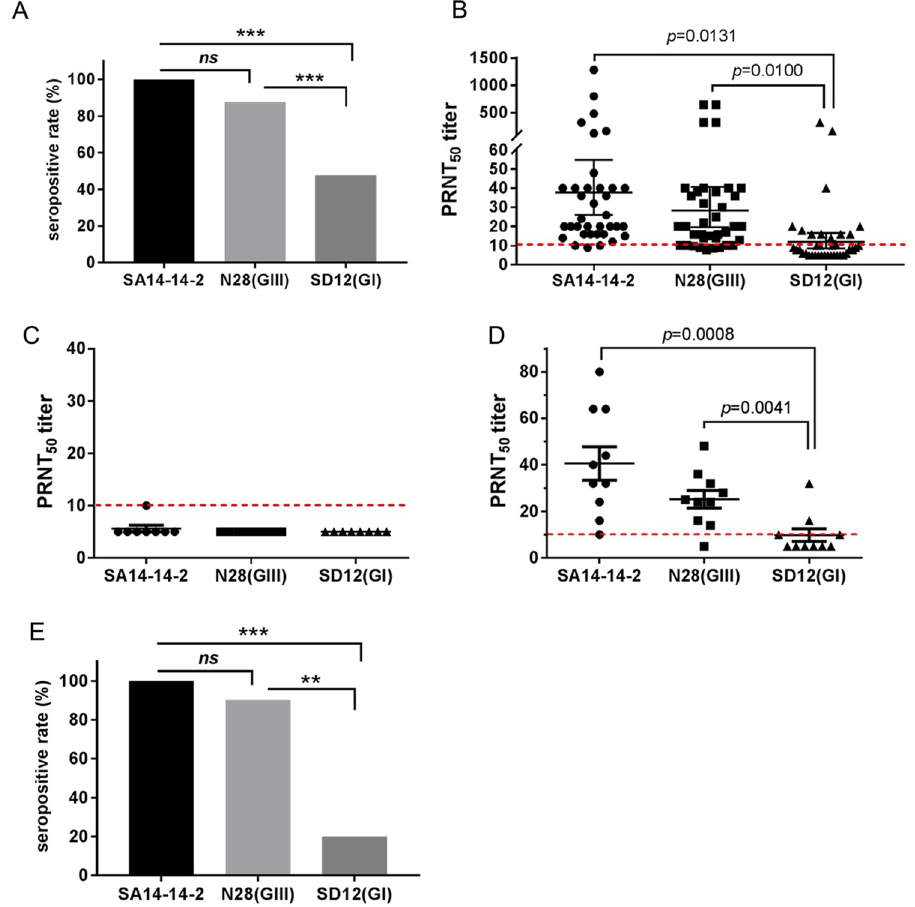
Fig 1. Detection of neutralizing antibody titers in pigs and mice vaccinated with the SA14-14-2 vaccine. (A and B) Pigs ( n = 40) were immunized with SA14-14-2 vaccine and serum samples for each animal were collected at 30 days post-vaccination for detection of neutralizing antibodies against SA14-14-2, N28(GIII) and SD12(GI) strains. (A) Seropositive rate against the indicated JEV strains. ��� , p < 0.001 detected by Fisher’s exact test. (B) Neutralizing antibody titers (PRNT 50 ) against the indicated JEV strains were measured on BHK-21 cells and plotted. A p value was generated by Student’s t -test. (C, D and E) Mice ( n = 10) were immunized with the SA14-14-2 vaccine and serum samples were collected at 14 days post-vaccination for detection of neutralizing antibodies against SA14-14-2 vaccine, N28(GIII) and SD12(GI) strains. (C) PRNT 50 titers in serum samples collected from pre-vaccinated mice. (D) PRNT 50 titers against the indicated JEV strains in serum samples collected from vaccinated mice. A p value was generated by Student’s t -test. (E) Seropositive rate against the indicated JEV strains. ��� , p < 0.001, �� , p < 0.01 detected by Fisher’s exact